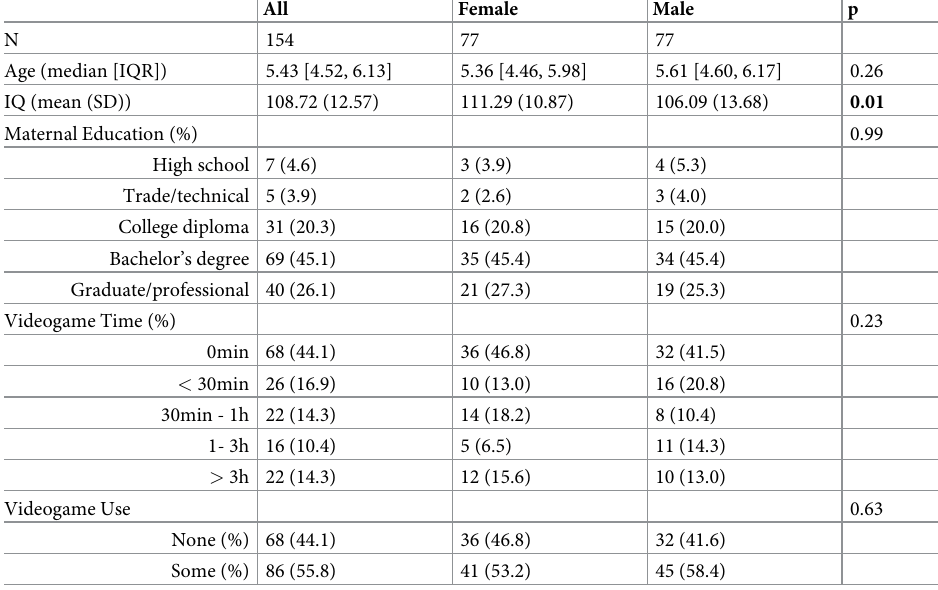
Table 1. Demographics, general cognition, time spent playing videogames, and videogame use. All